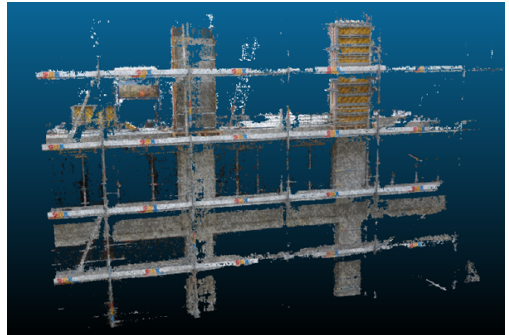
Figure 8. Extract of the point cloud containing the model planes shown in Figure 10.